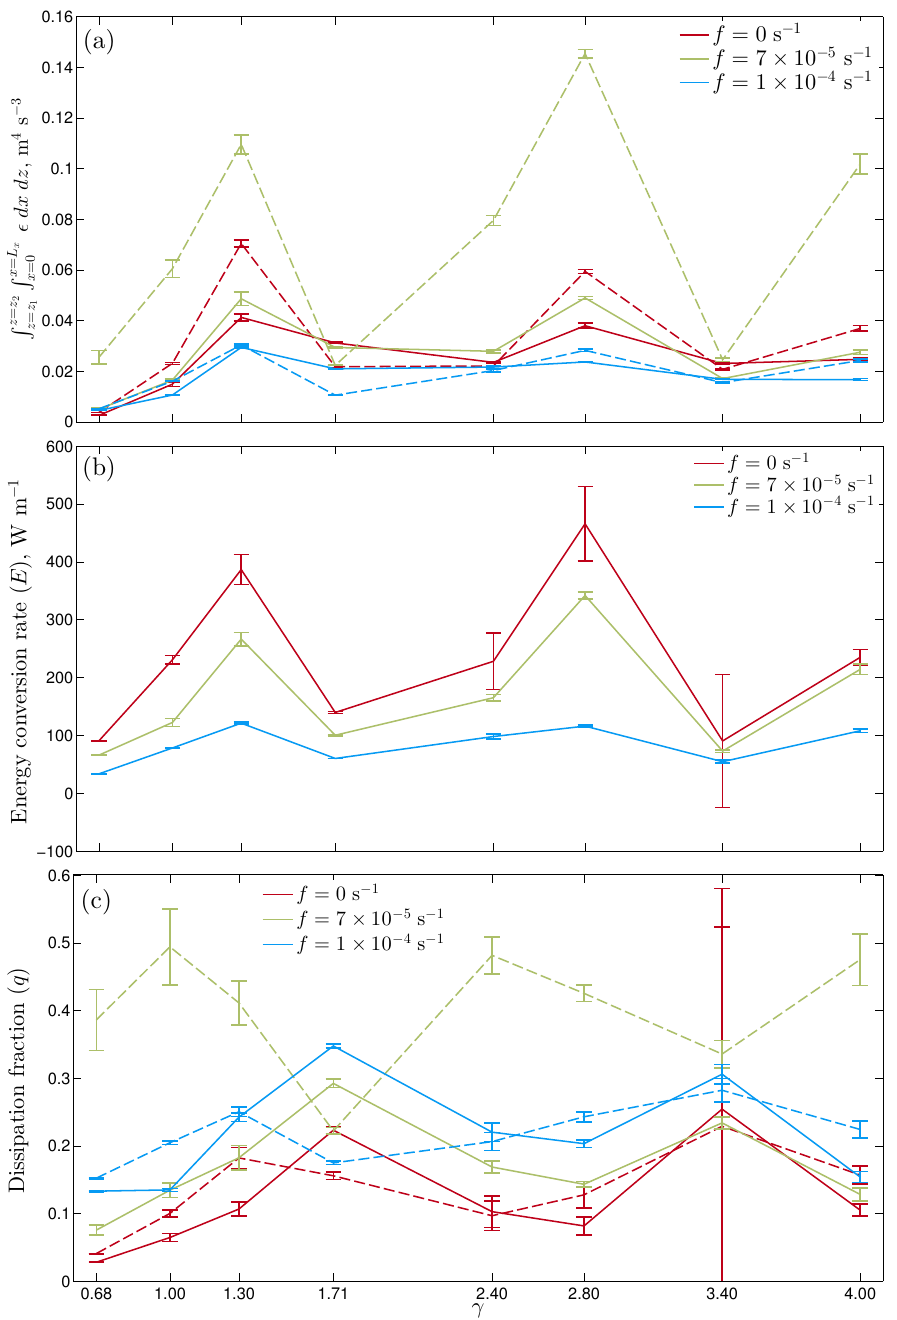
Figure 9. ( a ) Spatially-integrated and tidally-averaged kinetic energy dissipation rates (m 4 s − 3 ), where solid lines represent the dissipation vertically integrated from 0–50 m above the bottom (the bottom boundary layer, bbl) and dashed lines indicate the dissipation integrated from 50–2000 m above the bottom; ( b ) tidal-energy conversion rate (W m − 1 ); ( c ) dissipation fraction ( q ) plotted against the relative steepness ( γ ); q from 0–50 m above the bottom (solid lines) represents the dissipation fraction within the bbl, and q from 50–2000 m (dashed lines) above the bottom represents the dissipation fraction above the bbl. For all quantities error estimates ( 2 σ mean ) are also shown. The simulations are for three values of f (0 s − 1 , 7 × 10 − 5 s − 1 , and 10 − 4 s − 1 ), λ x = 6 km, and varying values of γ